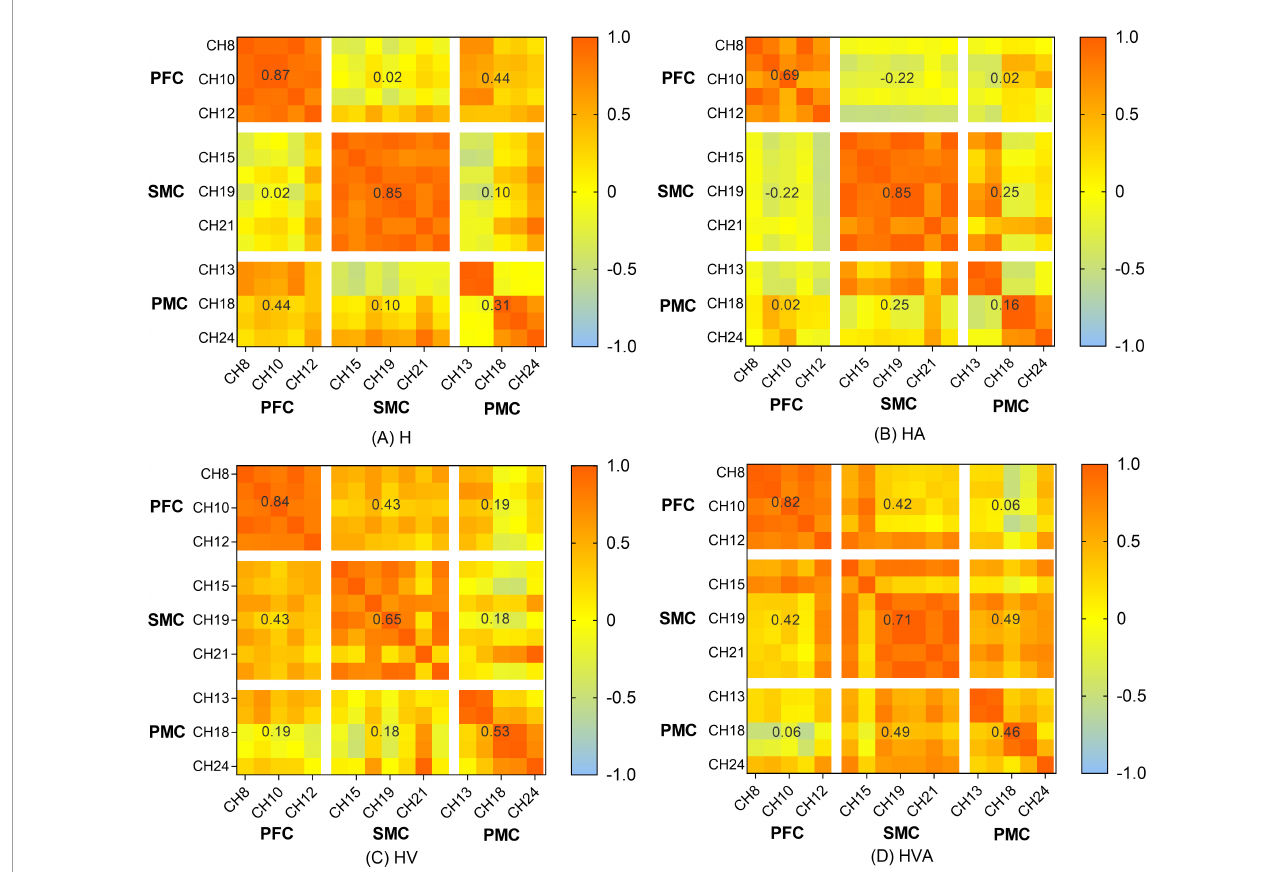
FIGURE9 Heat map of the connectivity among the channels. The matrix map includes all channel pairs. Color bars indicate the value of r . The x and y axes representing the ROIs indicate the dorsolateral prefrontal cortex (PFC, channels 8–12), somatosensory area (SMC, channels 14, 15, 17, 19–21, and 23), and premotor cortex (PMC, channels 13, 16, 18, 22, and 24). The abbreviations in the figure represent haptic (H), haptic + auditory (HA), haptic + visual (HV), and haptic + visual + auditory